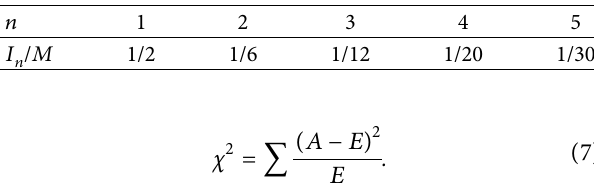
M value with n n /